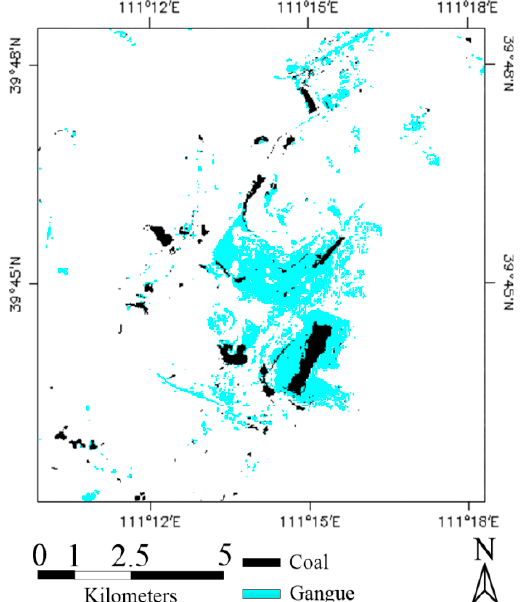
Figure 9. Application of the tree root based multi-layer extreme learning machine model in opencast Heidaigou coal mine area [106].